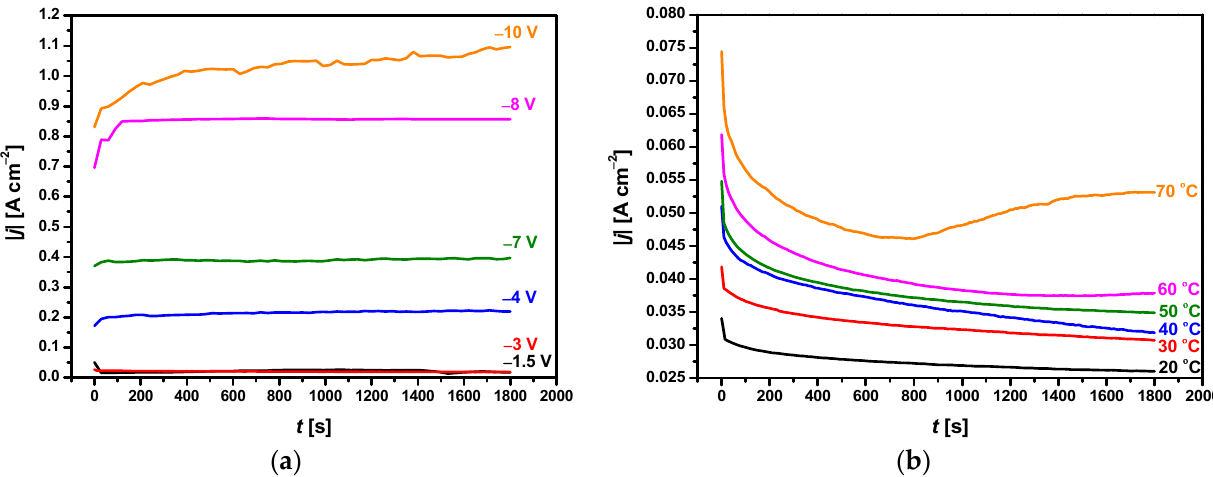
Figure 3. Chronoamperometric curves for ECAD of the CaP coatings on the CpTi G4 substrate in the acetate bath as a function of: ( a ) Deposition potential at room temperature; ( b ) Bath temperature at the deposition potential of − 3 V.